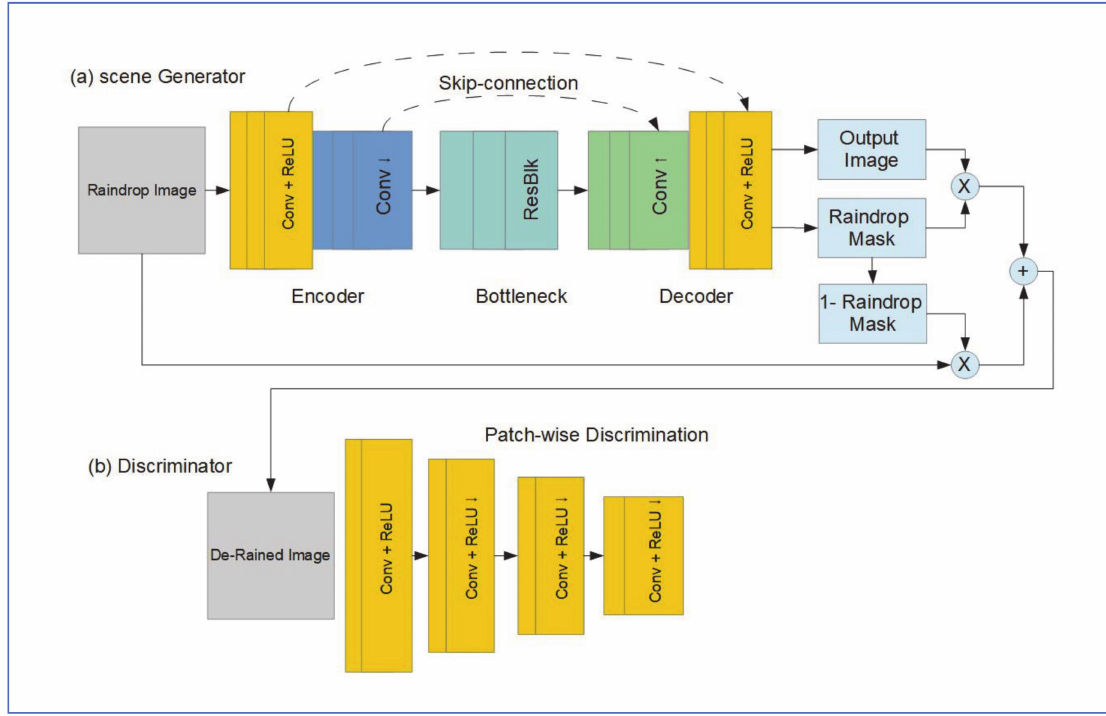
Figure 24. Structure Raindrop-Aware GAN raindrop removal network, as proposed by Kim et al. [61].